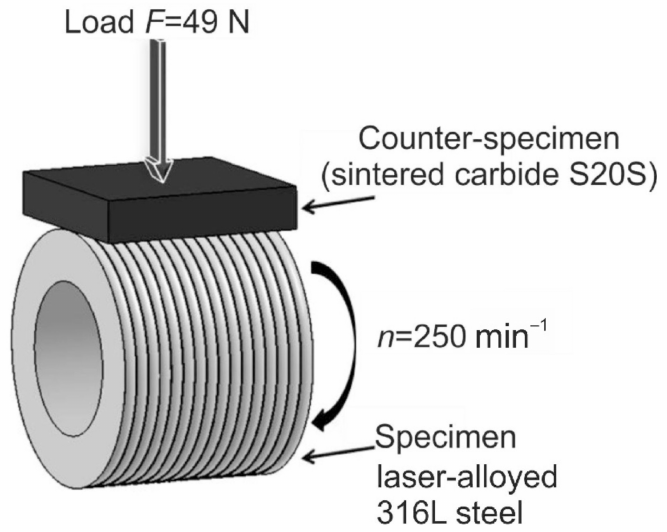
Figure 3. The scheme of the frictional pair during wear tests of laser-alloyed layers, produced in austenitic 316L